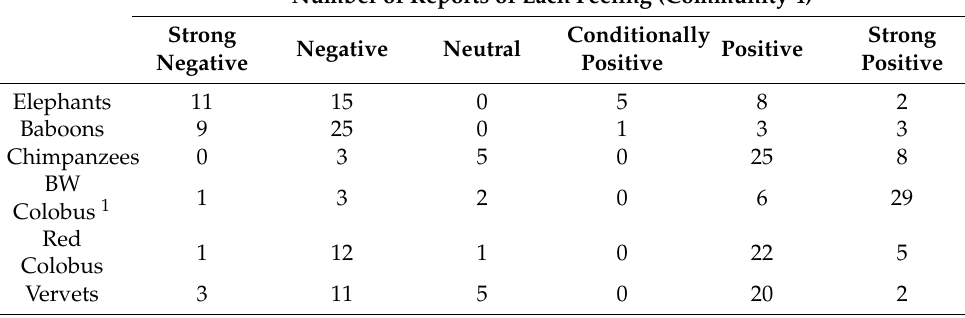
Table 3. Reported feelings of Community 4 ( n = 41, top) and participating communities ( n = 93, bottom) toward different animal species within and around Kibale National